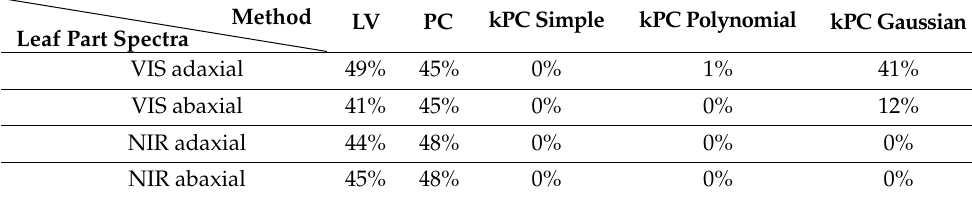
Table 5. Common classification error (e, %) of the Naïve Bayes classifier. Leaf Part